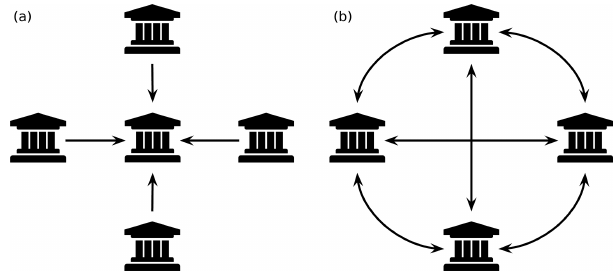
Figure 2. Data flows in two different soil information system in- frastructures: (a) centralised; (b)